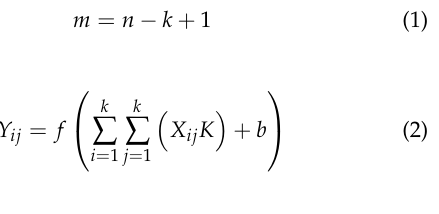
selection algorithm based on improved particle swarm op- timization(PSO), introduced a new PSO algorithm with strong convergence ability by combining chaos